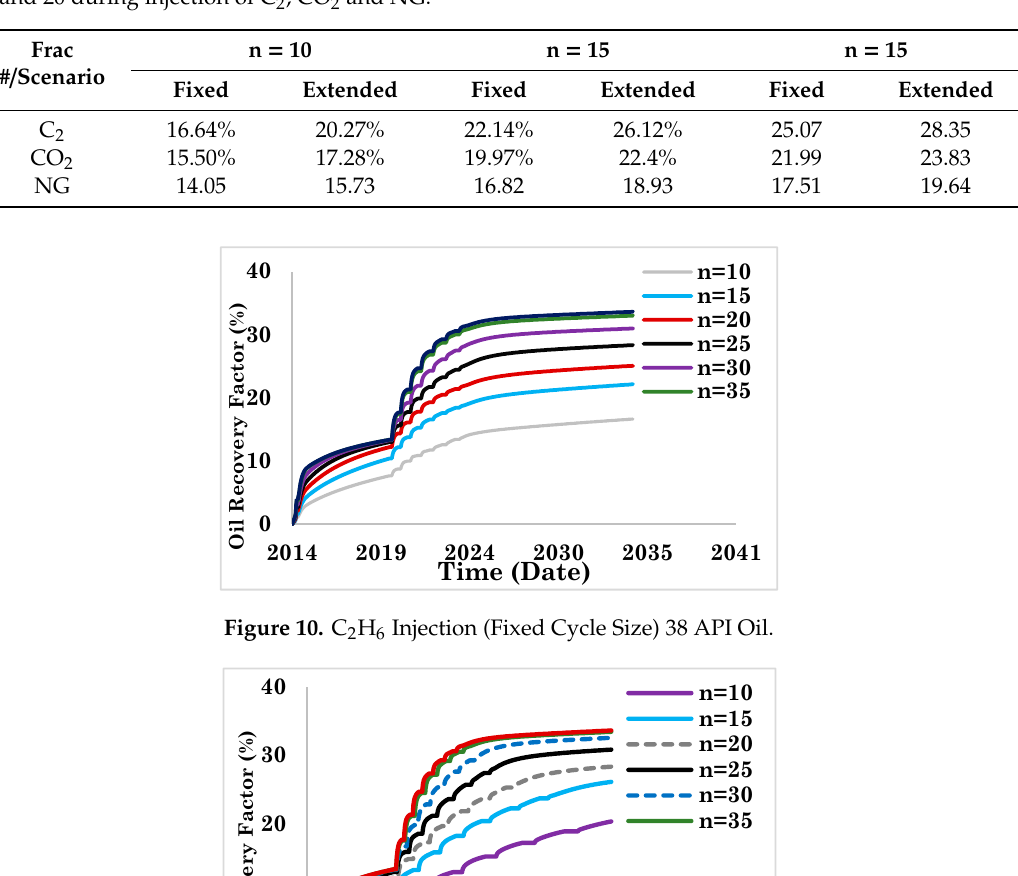
Figure 12. CO 2 Injection (Fixed Cycle Size) 38 API Oil.